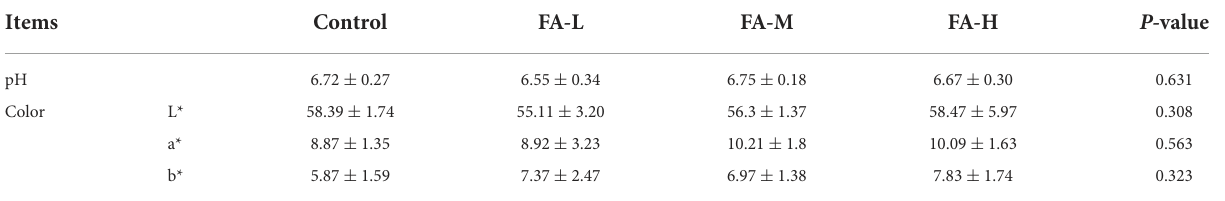
TABLE 5 The pH and meat color at 45min of breast muscle (Mean ±